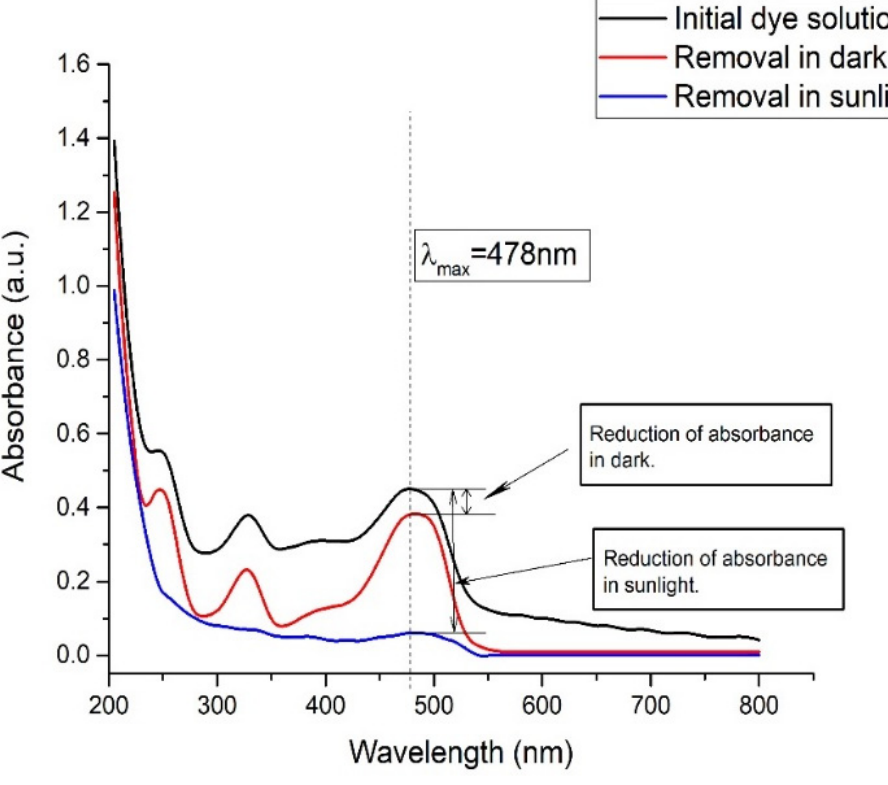
Figure 13. Comparison of removal of Orange G in darkness and in presence of sunlight for Composite 3 (TP 0.75 CS 0.25 ) .